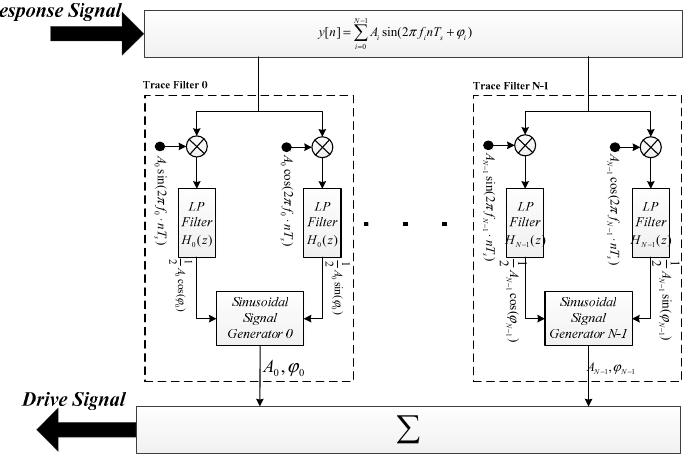
Figure 2. The parallel structure of digital tracking filters.